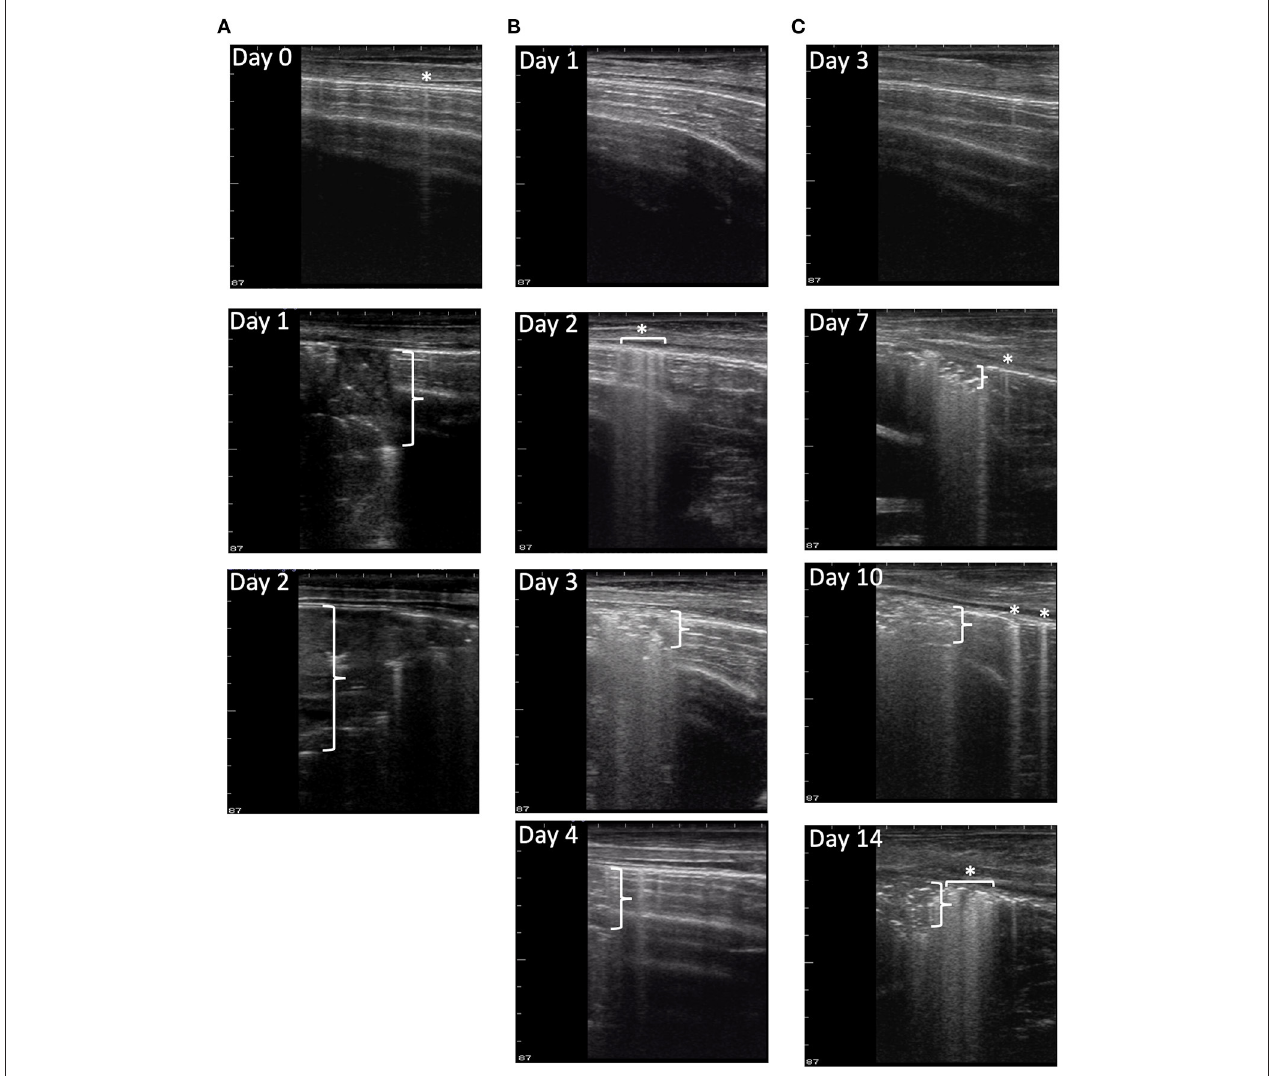
FIGURE 3 | Progression of disease in ultrasound images. Ultrasound images were collected from nine locations each day for each calf in the study. (A) depicts ultrasound image progression from location 14R on days 0, 1, and 2 of a M. haemolytica –infected calf from the Fall 2019 cohort. The final TUS scores of the calf were 0, 4, and 4, and its clinical scores were 2, 7, and 9, respectively. The calf was euthanized on day 2 after infection because of the severity of disease progression. (B) depicts the ultrasound image progression from location 18L on days 1, 2, 3, and 4 of a M. haemolytica –infected calf from the Summer 2020 cohort. The final TUS scores of the calf were 1, 1, 4, and 4, and its clinical scores were 4, 4, 7, and 2, respectively. The calf was euthanized on day 4 after infection. (C) depicts the ultrasound image progression from a location 18L on days 3, 7, 10, and 14 of a representative BRSV-infected calf. The final TUS scores of calf were 0, 3, 3, and 3, and its clinical scores were 1, 9, 6, and 2, respectively. The calf was euthanized on day 14 after infection. Asterisks with or without horizontal brackets indicate pleural defects and vertical brackets indicate maximum depth of consolidation.